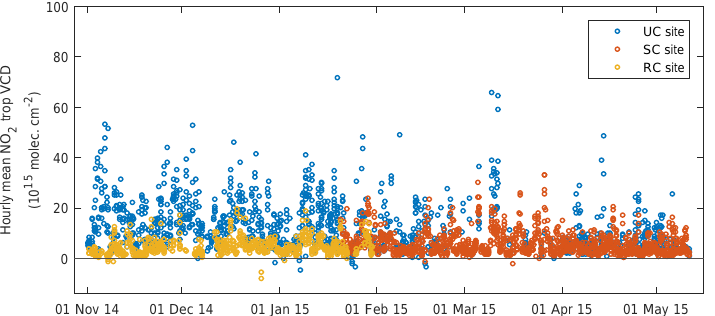
Figure 7. Time series of hourly mean tropospheric NO 2 VCD measurements performed at 15 and 30 ◦ elevation angles by Phaethon at the three campaign